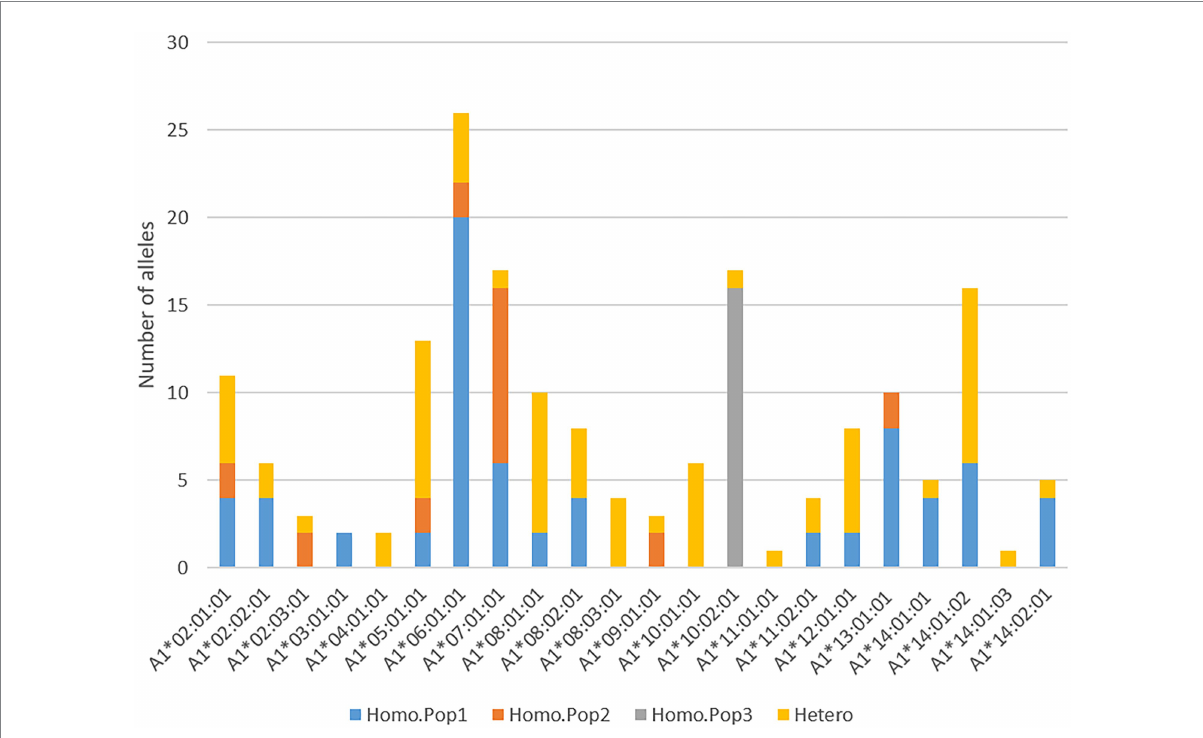
FIGURE 6 Homozygosity at A1 locus. Diagram shows the number of homozygous A1 alleles per each of the three populations where blue defines homozygous alleles from population 1 (Homo.Pop 1), red from population 2 (Homo.Pop 2), and grey from population 3 (Homo.Pop 3), while remaining alleles in heterozygous (Hetero) pairs in all populations are shown using